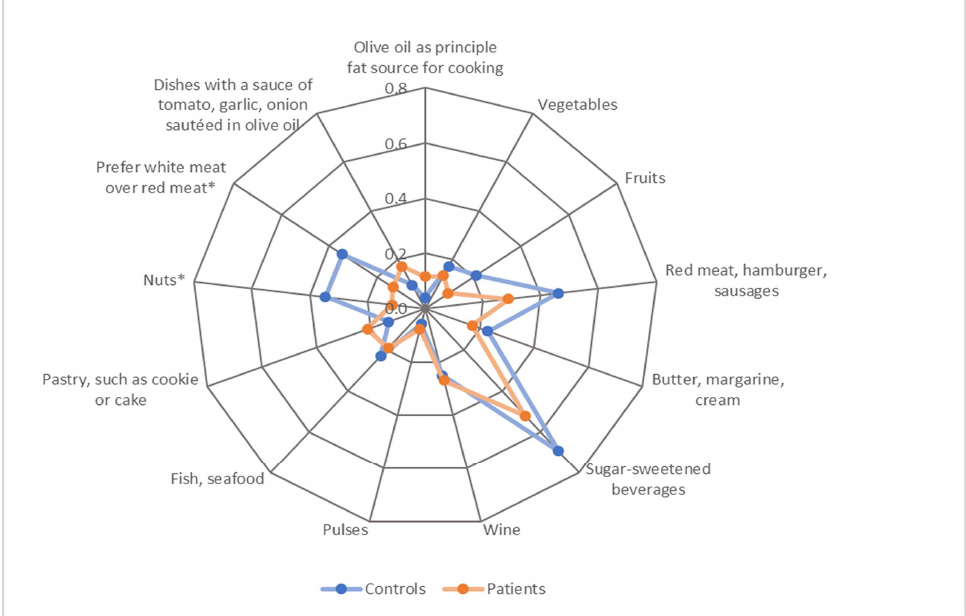
Figure 2. Dietary patterns of patients and controls according to average scores achieved for items in the Mediterranean Diet Adherence Screener (MEDAS). Note. The category “Olive oil, rapeseed oil” was excluded as no participant scored. Scores ranged between 0–1 point. * p < 0.05. Detailed numerical results are presented in Table S4.